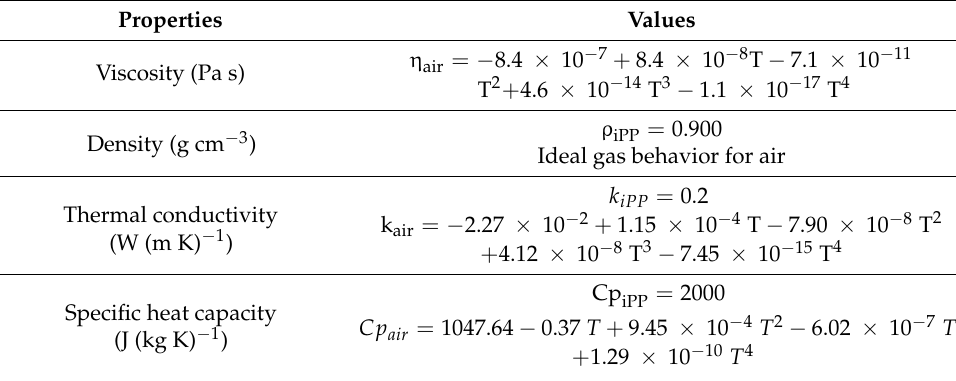
Table 2. Properties adopted to model the